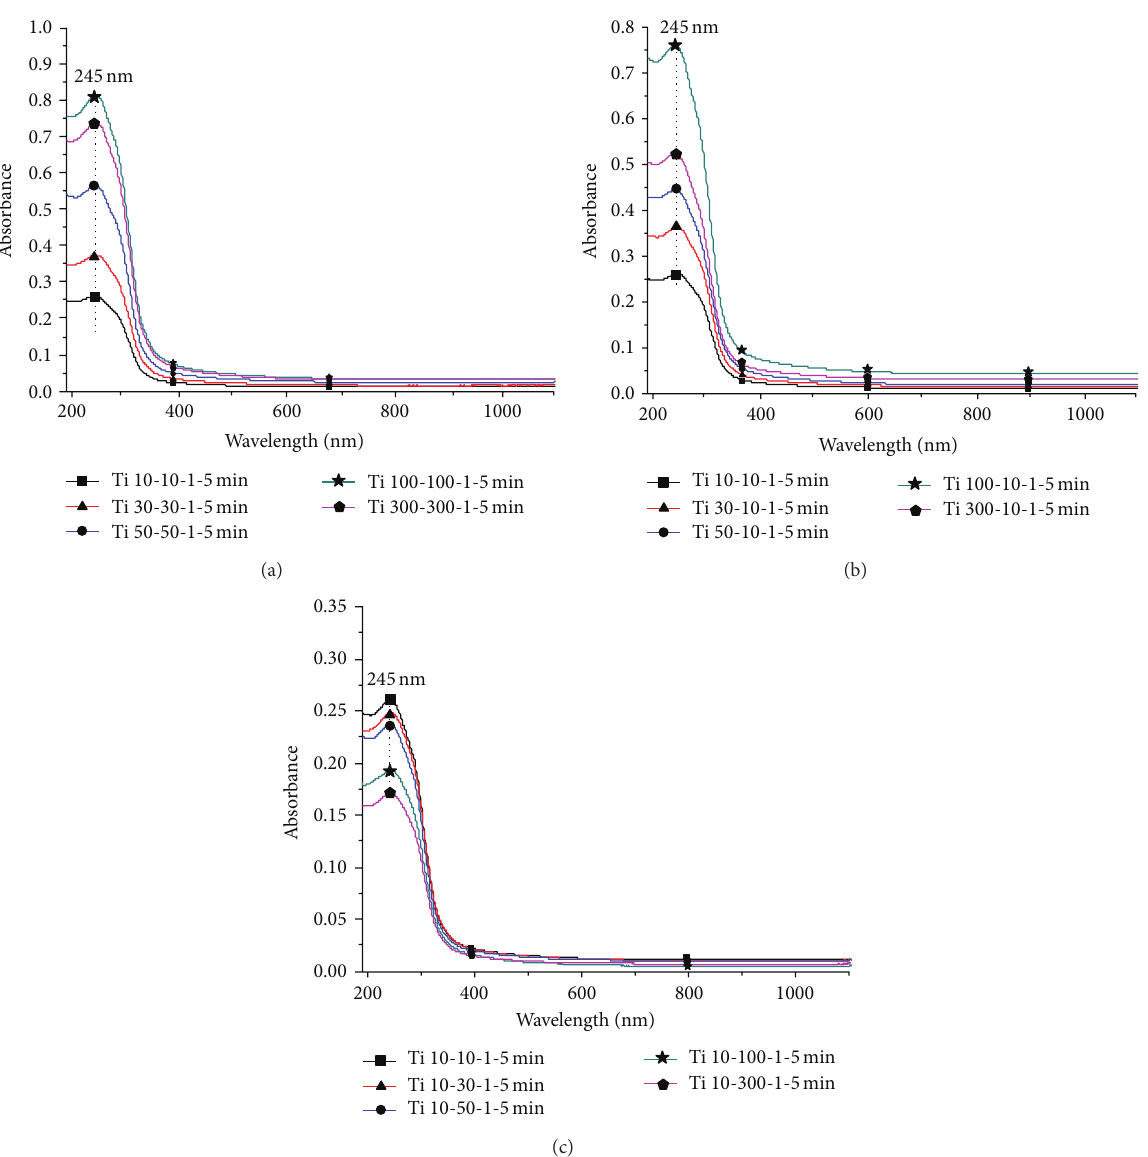
Figure9:TitaniumfluidUV-Visanalysisresults.(a) 𝑇